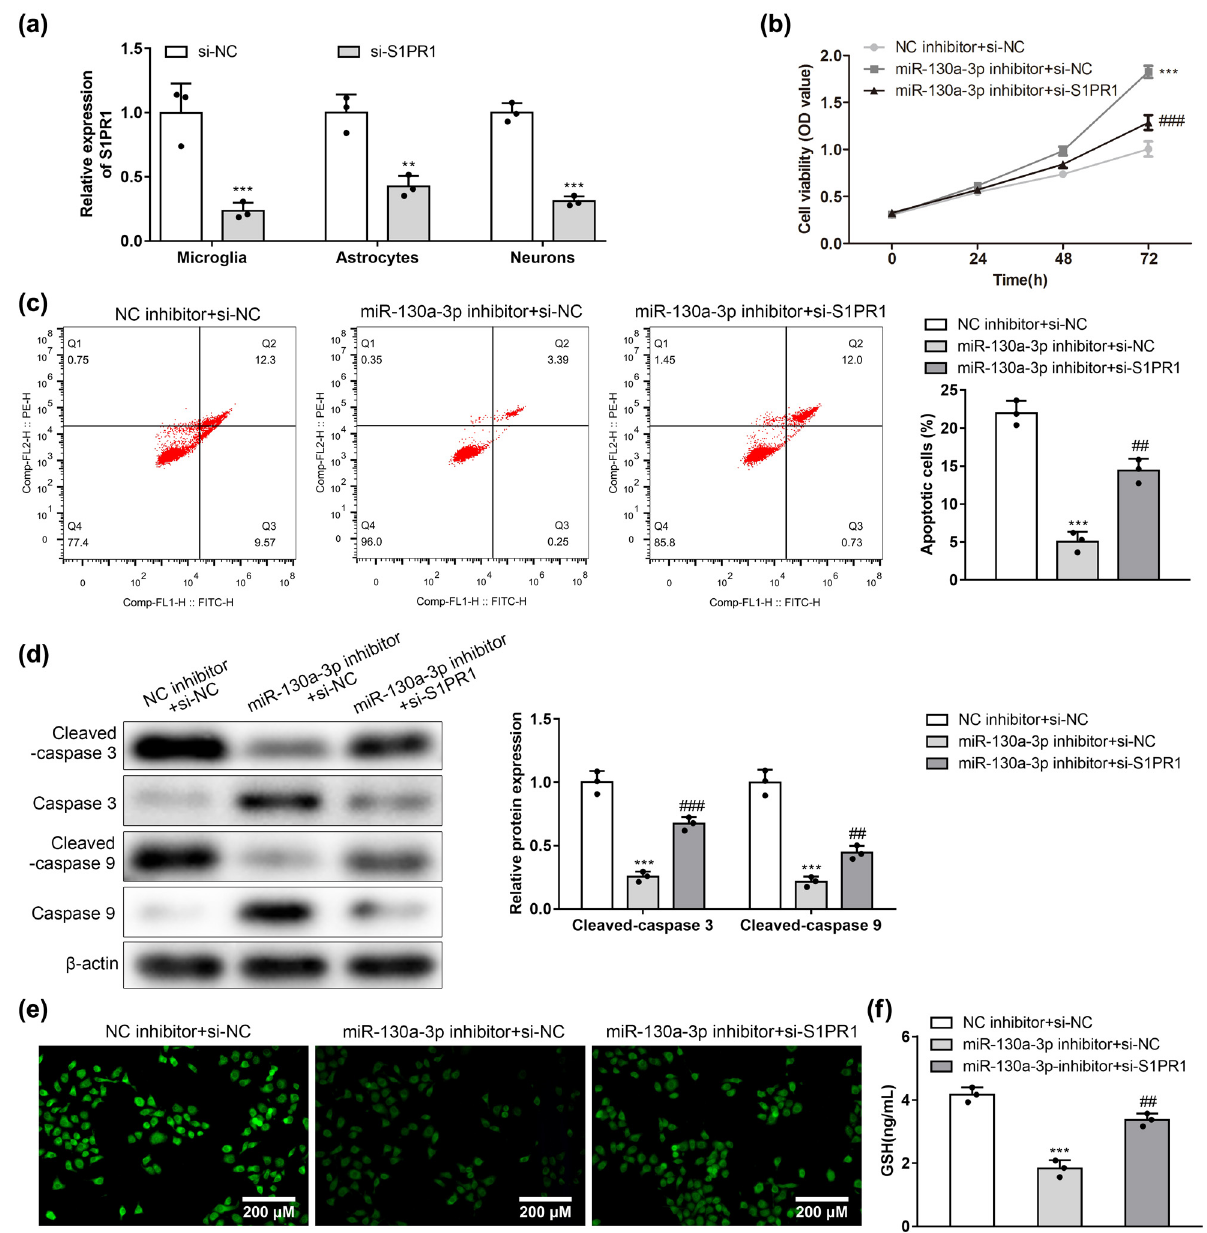
Figure 6: Rescue e ff ects of silenced S1PR1 on silenced miR - 130a - 3p in apoptosis and oxidative stress of the HG - induced neurons. ( a ) The expression of S1PR1 was assessed in microglia, astrocytes, and neurons transfected with si - S1PR1 by RT - qPCR. ( b ) Viability of HG - stimu - lated neurons under the transfection of miR - 130a - 3p inhibitor or cotransfection of miR - 130a - 3p inhibitor + si - S1PR1 was determined by a CCK - 8 kit. ( c ) Flow cytometry apoptosis analysis of HG - stimulated neurons. ( d ) Rescue e ff ects of si - S1PR1 on miR - 130a - 3p inhibitor in cleaved caspase 3/9 proteins in HG - treated neurons, as revealed by western blotting. Rescue e ff ects of si - S1PR1 on miR - 130a - 3p inhibitor in ROS ( e ) and GSH ( f ) levels. *** P < 0.001 vs NC inhibitor + si - NC; ## P < 0.01, ### P < 0.001 vs miR - 130a - 3p inhibitor + si -